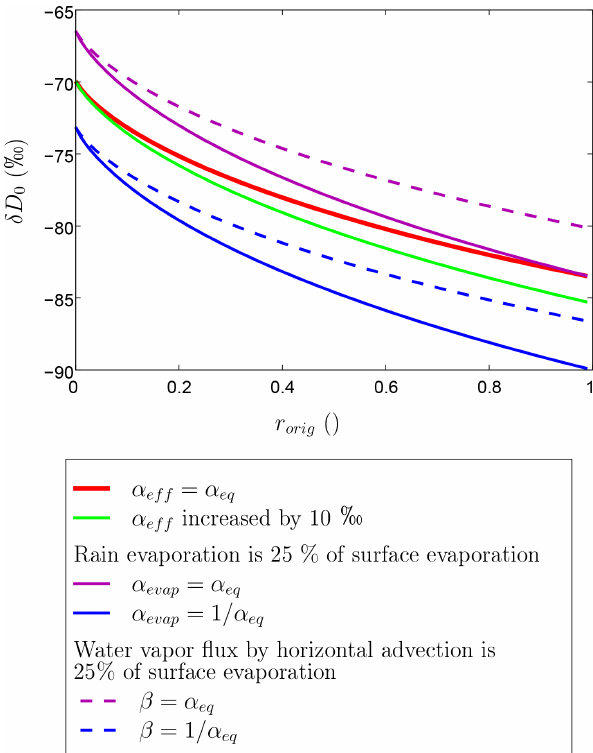
Figure 3. δD 0 as a function of r orig according to Eq. (9), with α eff = α eq as an example (red). For this illustrative purpose, we assume SST = 30 ◦ C, h 0 = 0 . 8, δD oce = 0‰, and φ = η = 0. The sensitivity to the effective fractionation factor α eff (green) is shown. If rain evaporation is 25% of surface evaporation ( η = 0 . 25), the solid pink and blue curves show the sensitivity to the effective frac- tionation factor α evap . If the incoming water vapor by horizontal ad- vection is 25% of surface evaporation ( φ = 0 . 25), the dashed pink and blue curves show the sensitivity to the isotopic gradient quanti- fied by β